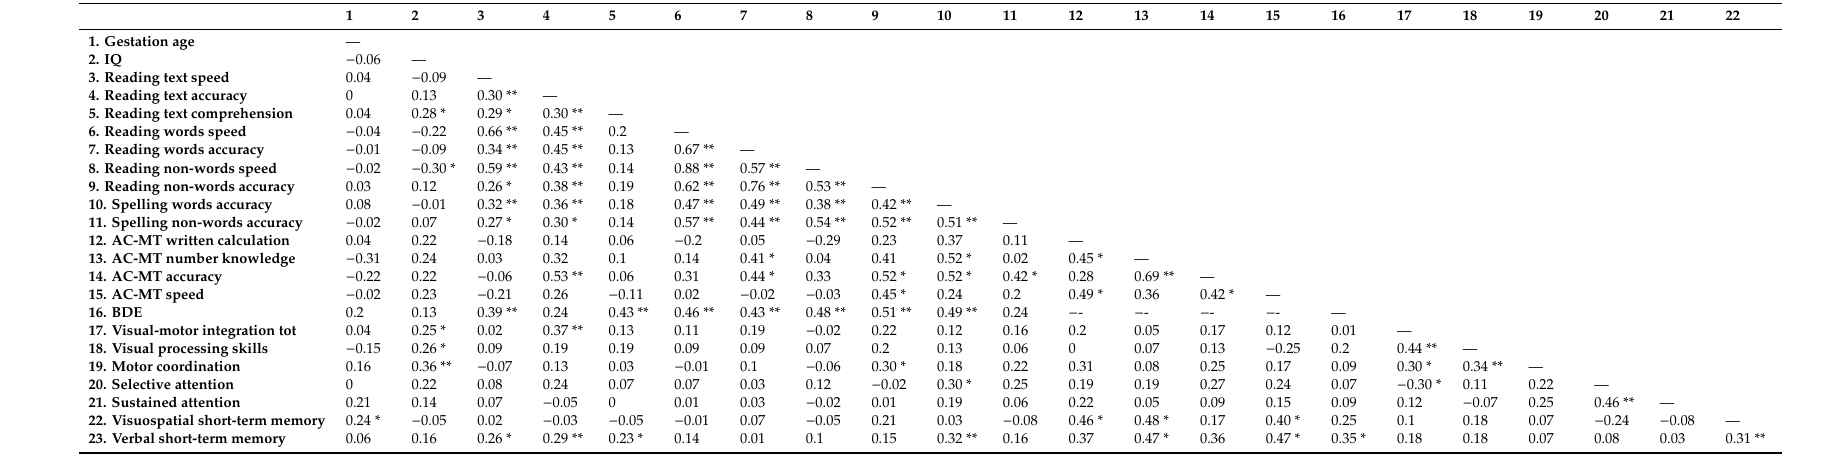
Table 5. Correlations between the learning abilities and the neurocognitive